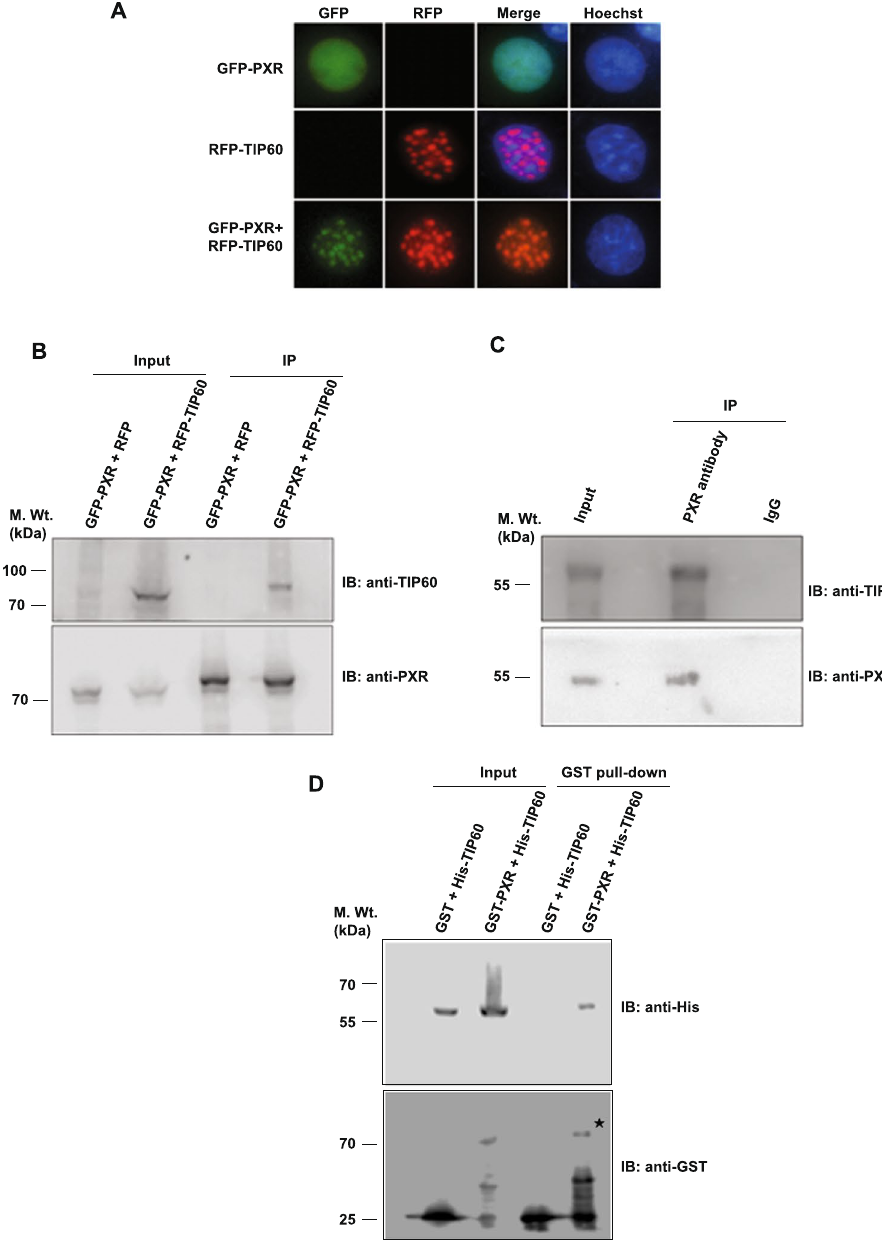
Figure 1. TIP60 modulates intranuclear dynamics of PXR and physically interacts with it. ( A ) Cos-1 cells were transfected with GFP-PXR and RFP-TIP60 plasmids alone or together and live cell imaging was performed to monitor their subcellular localization. ( B ) Cos-1 cells were transfected with GFP-PXR and RFP-TIP60 or RFP plasmids. Anti-PXR antibody was used for immunoprecipitation and immunoprecipitated proteins were resolved by SDS-PAGE. Immunoblotting was performed using anti-PXR or anti-TIP60 antibodies as indicated. Input lanes contain 10% of lysate used for immunoprecipitation. ( C ) To investigate endogenous interaction of TIP60 and PXR, endogenous PXR was immunoprecipitated from HepG2 cells using anti-PXR or control mouse IgG antibodies. Bound proteins were resolved by SDS-PAGE followed by immunoblotting with anti-PXR or anti-TIP60 antibodies. ( D ) TIP60 and PXR directly interact with each other. His-TIP60 and GST-PXR or GST alone were cotransformed and pull-down of glutathione-agarose-bound proteins was performed. Samples were resolved and immunoblotting was performed using anti-His or anti-GST antibodies. Asterisk indicates full- length band of GST-PXR protein. Full-length immunoblots are presented in Supplementary Figure